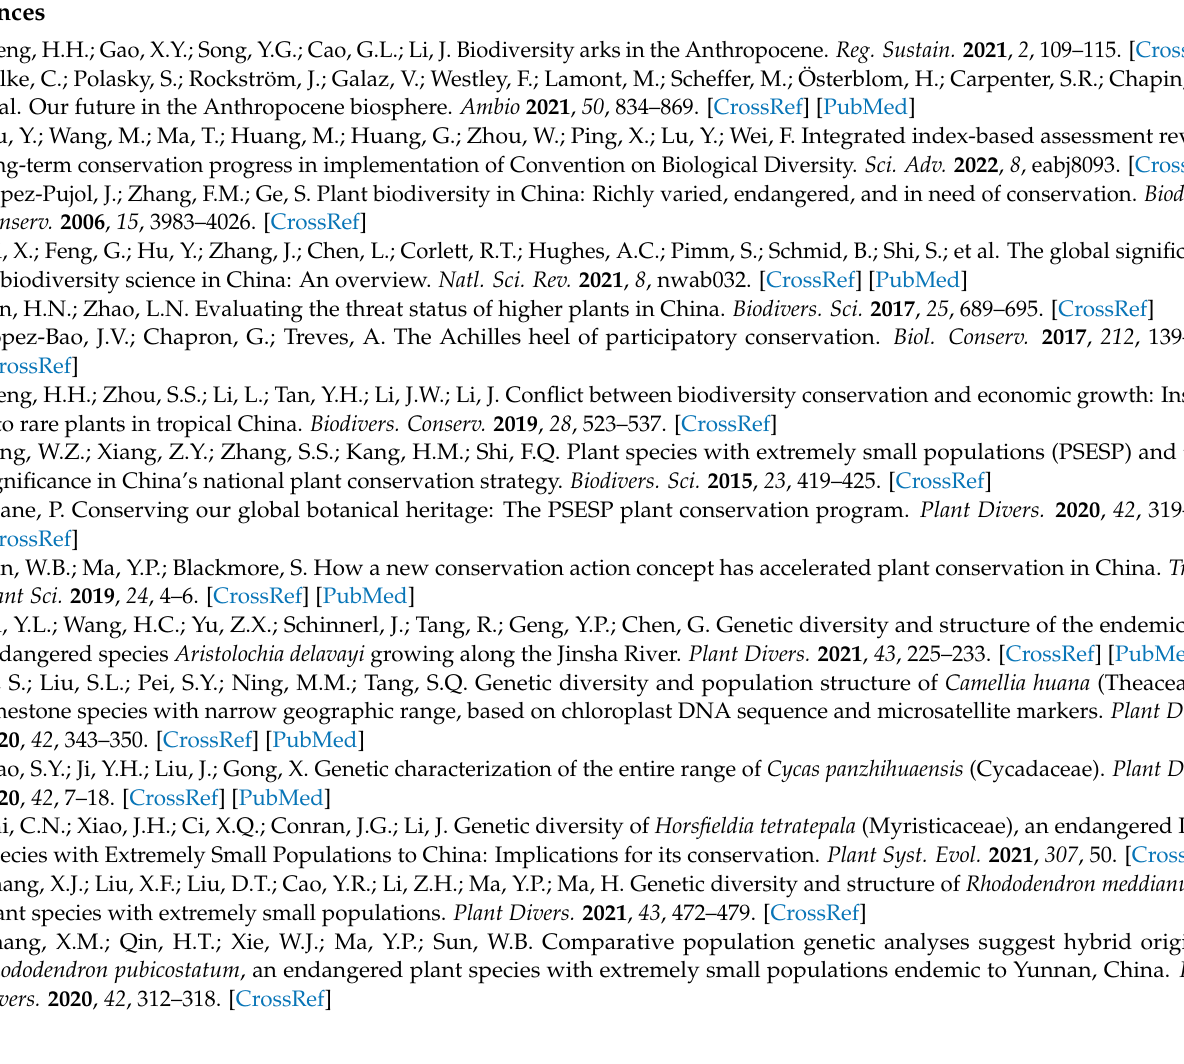
analysis; Figure S4: OptM results for TreeMix when run from 0 - 6 migration event(s); Table S1: Three-population test for T. doichangensis ; Table S2: Four-population test for T. doichangensis